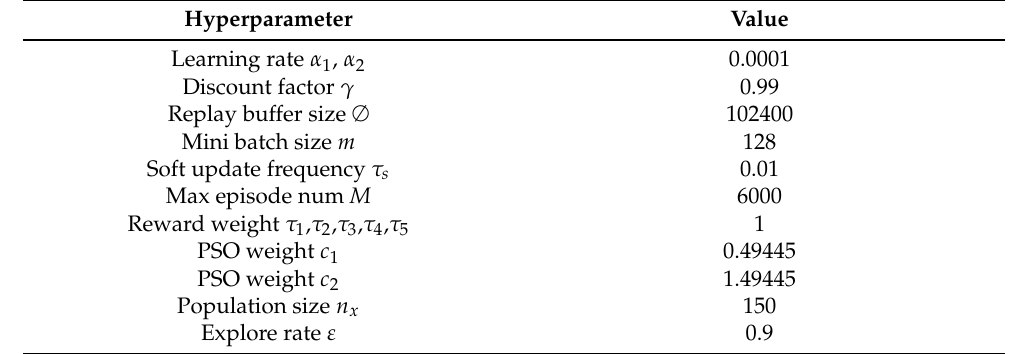
Table 1. Hyperparameters of GSAC, SAC and DQN.